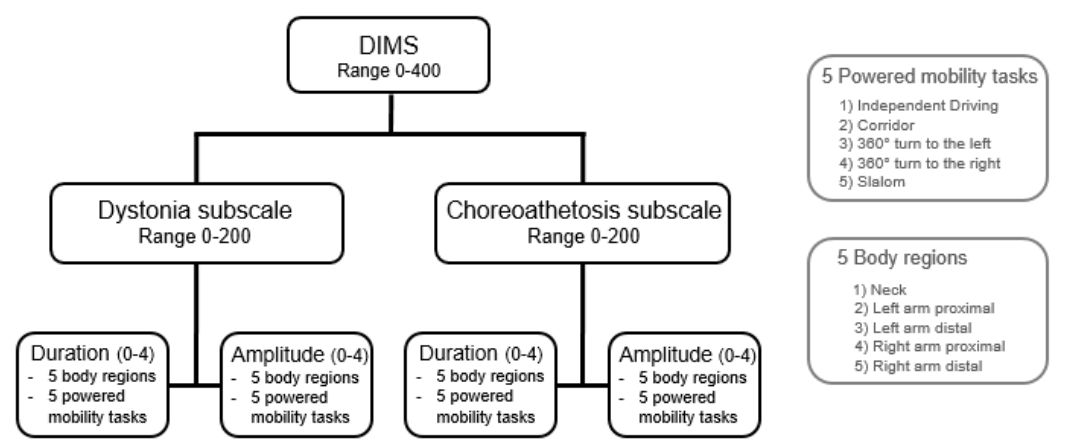
Figure 1. Diagram of the Dyskinesia Impairment Mobility Scale (DIMS) protocol. Table 1. Scoring protocol of the Dyskinesia Impairment Mobility Scale (DIMS) duration and amplitude during powered mobility.